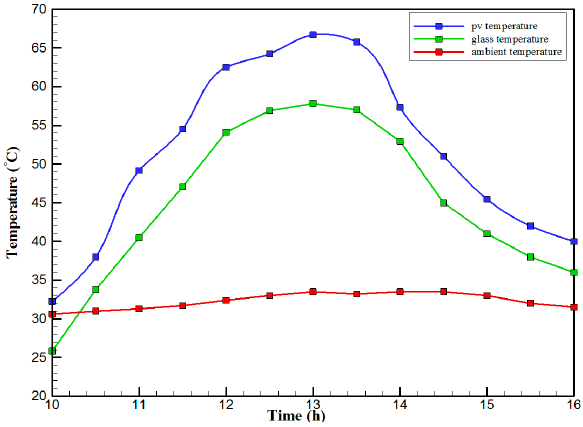
Figure 8. The hourly variation of PV, glass and ambient temperature for the PVT solar collector with CPC.